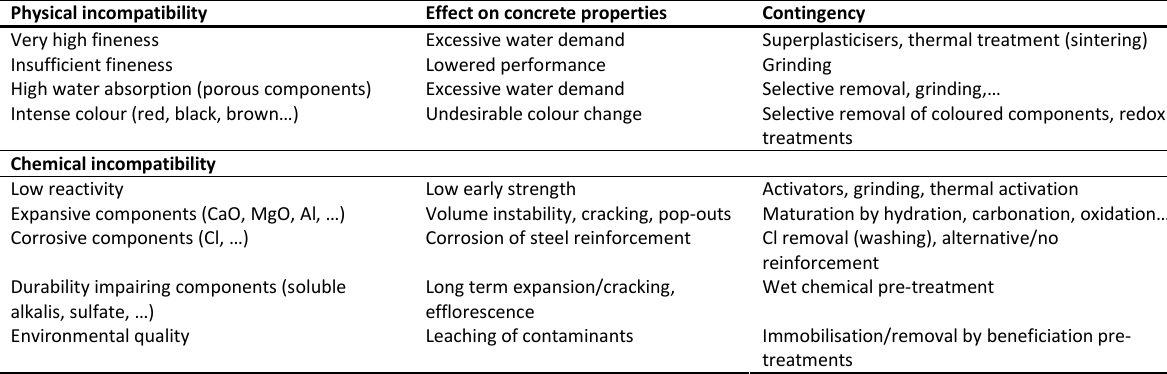
Table 1. Challenging SCM properties for blended cements Physical incompatibility